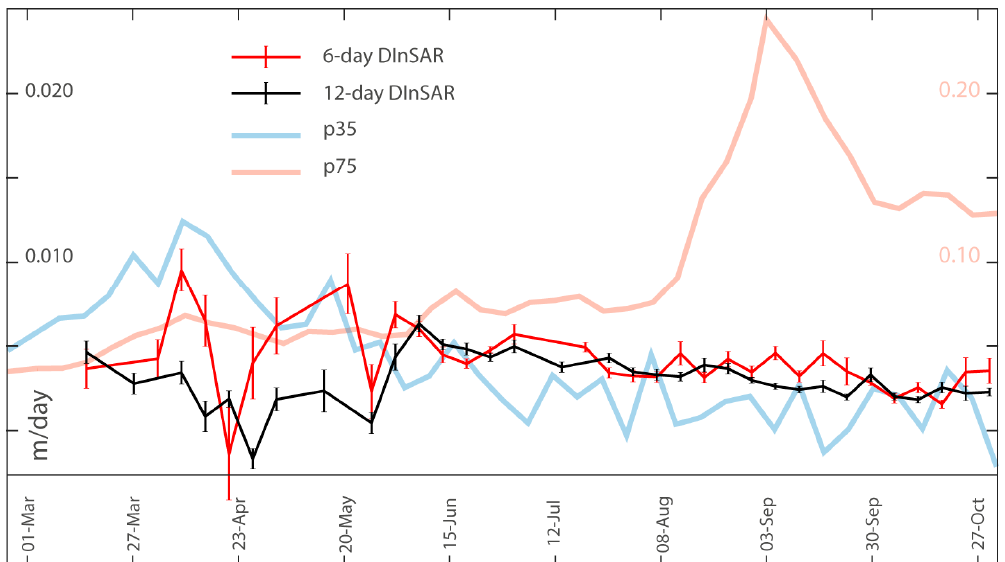
Figure 5. Comparison of DInSAR vs. ground measurements of surface velocities at Moosfluh rock slope instability during the period March–October 2017. DInSAR velocities are the average LOS displacements measured in the upper portions of Moosfluh. Error bars show standard deviations. The point p35 is located in the upper portion of the slope, while p75 on the lower portions (see geographic location in Figure 1). Ground measurements are projected towards the satellite LOS. Note: velocities of p75 are one order of magnitude higher, values are on the right y-axis.